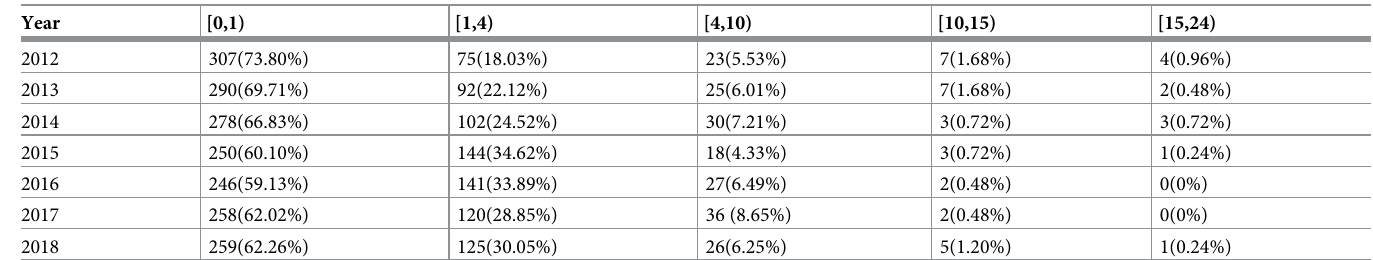
Table 4. Malaria RR per year as compared to the year 2012.